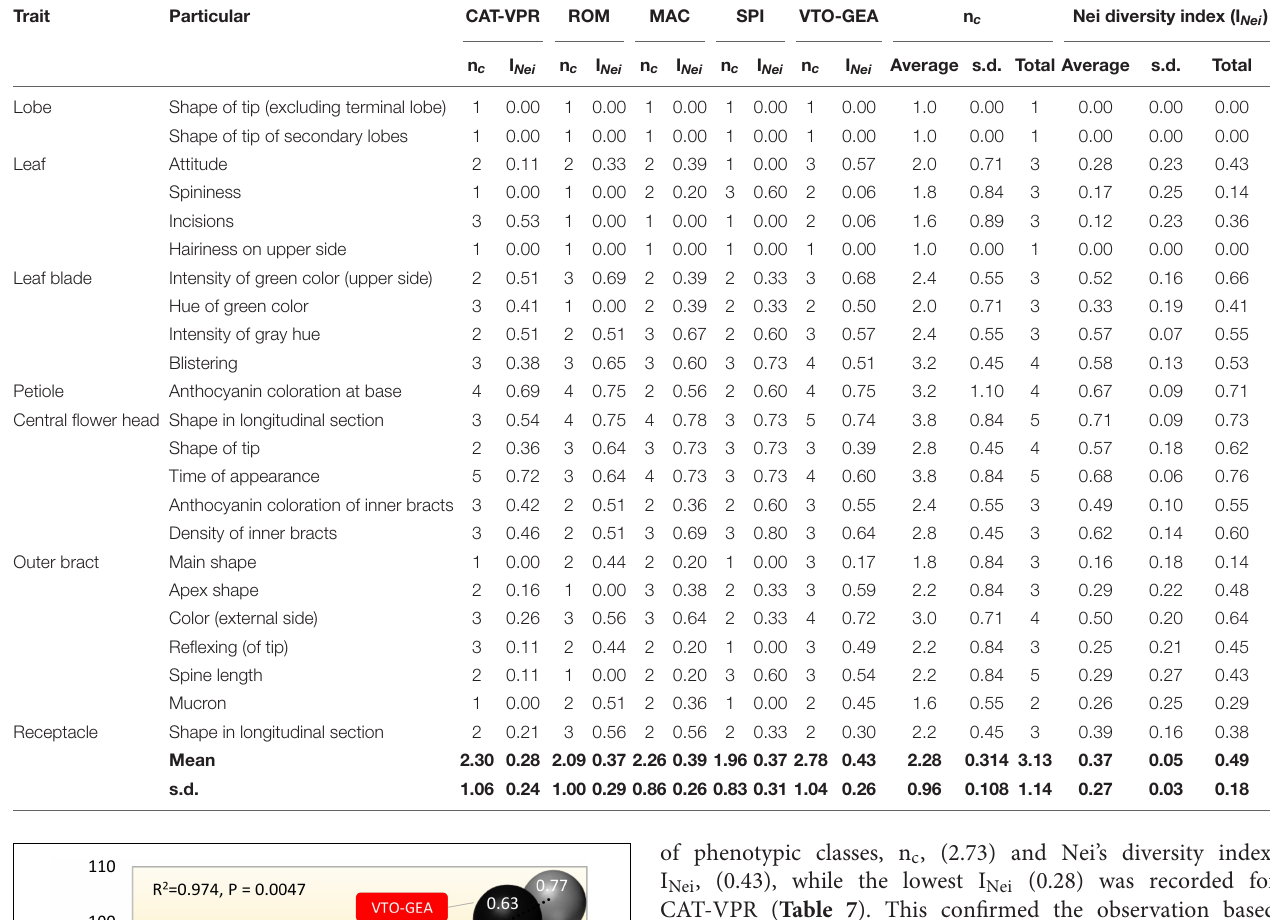
TABLE 7 | Diversity statistics (Nei’ diversity index, I Nei , and number of phenotypic classes, n c ) for the 23 UPOV descriptors applied within and between the five SSR groups of the cultivated globe artichoke. Trait Particular